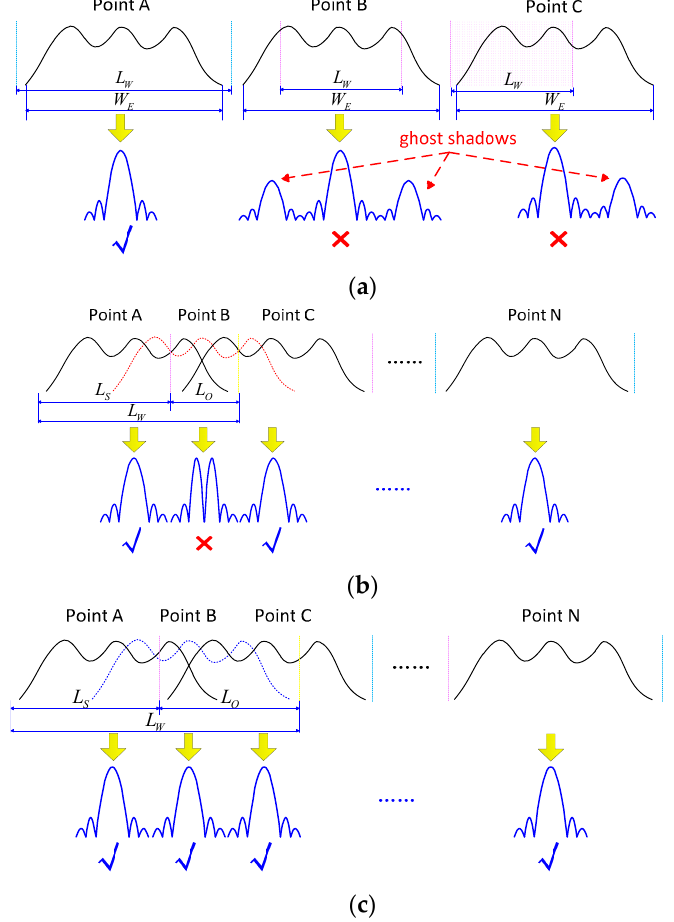
Figure 2. Illustration of sliding parameters for the post-filtering strategy: ( a ) Window length restriction for single point; ( b ) A failure case of sliding parameters for point array; ( c ) A successful case of sliding parameters for point array.